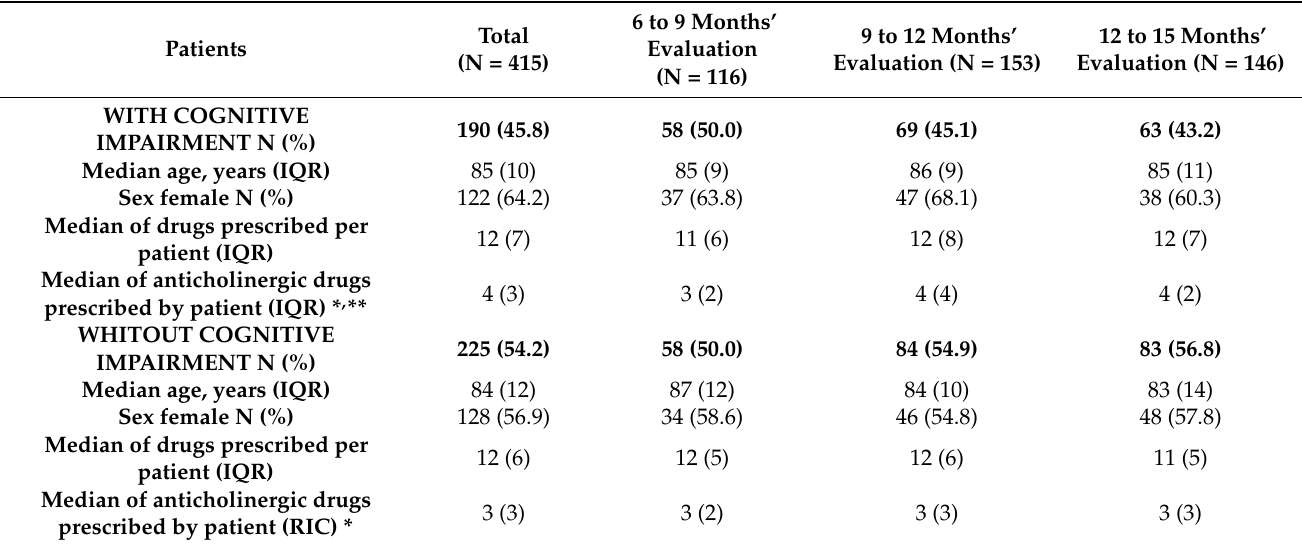
Table 2. Demographic and pharmacological data according to cognitive impairment and by time subgroups.